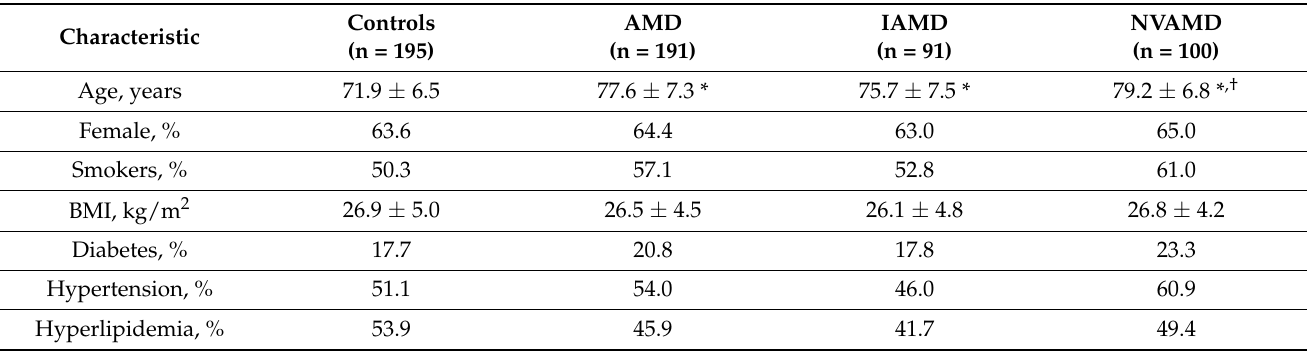
Table 1. Study Population